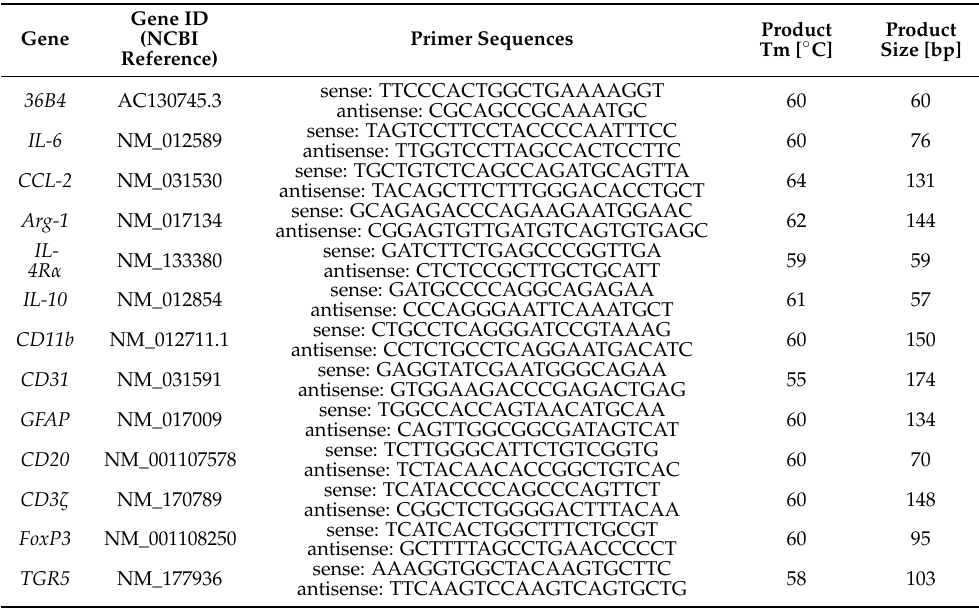
Table 1. Primer sequences used in quantitative